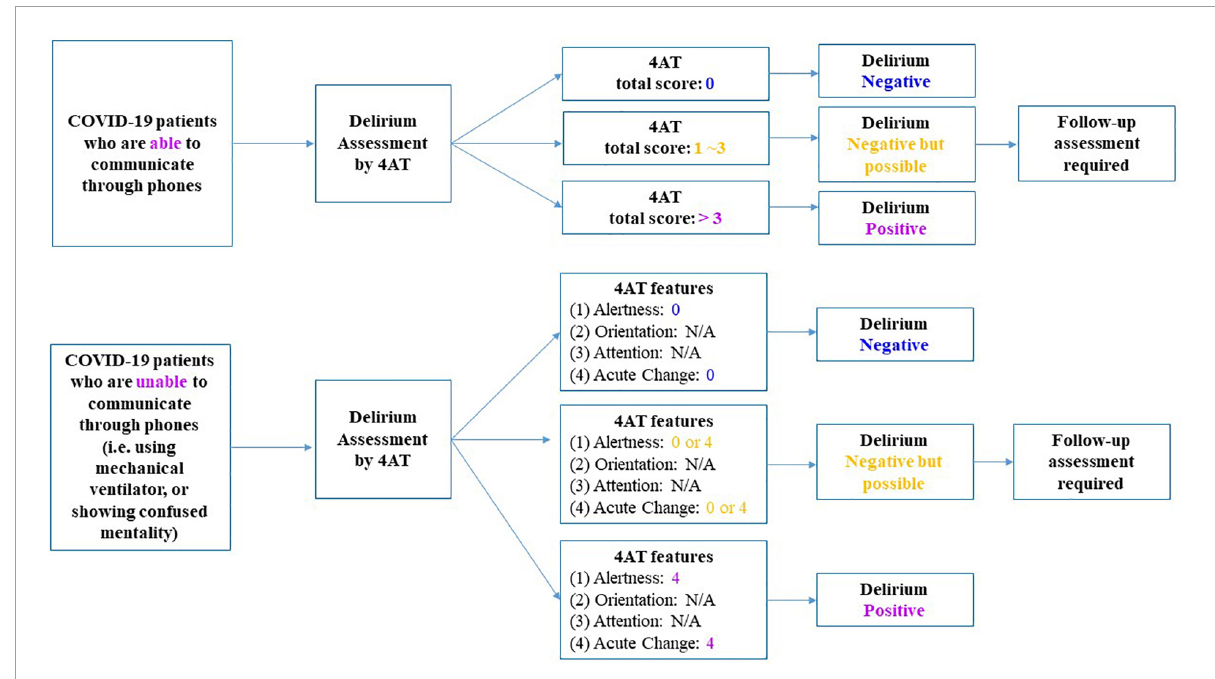
FIGURE1 Protocol of delirium screening by 4‘A’s Test (4AT) for Coronavirus disease 2019 (COVID-19) inpatients. 4AT, 4‘A’s Test; COVID-19, Coronavirus disease